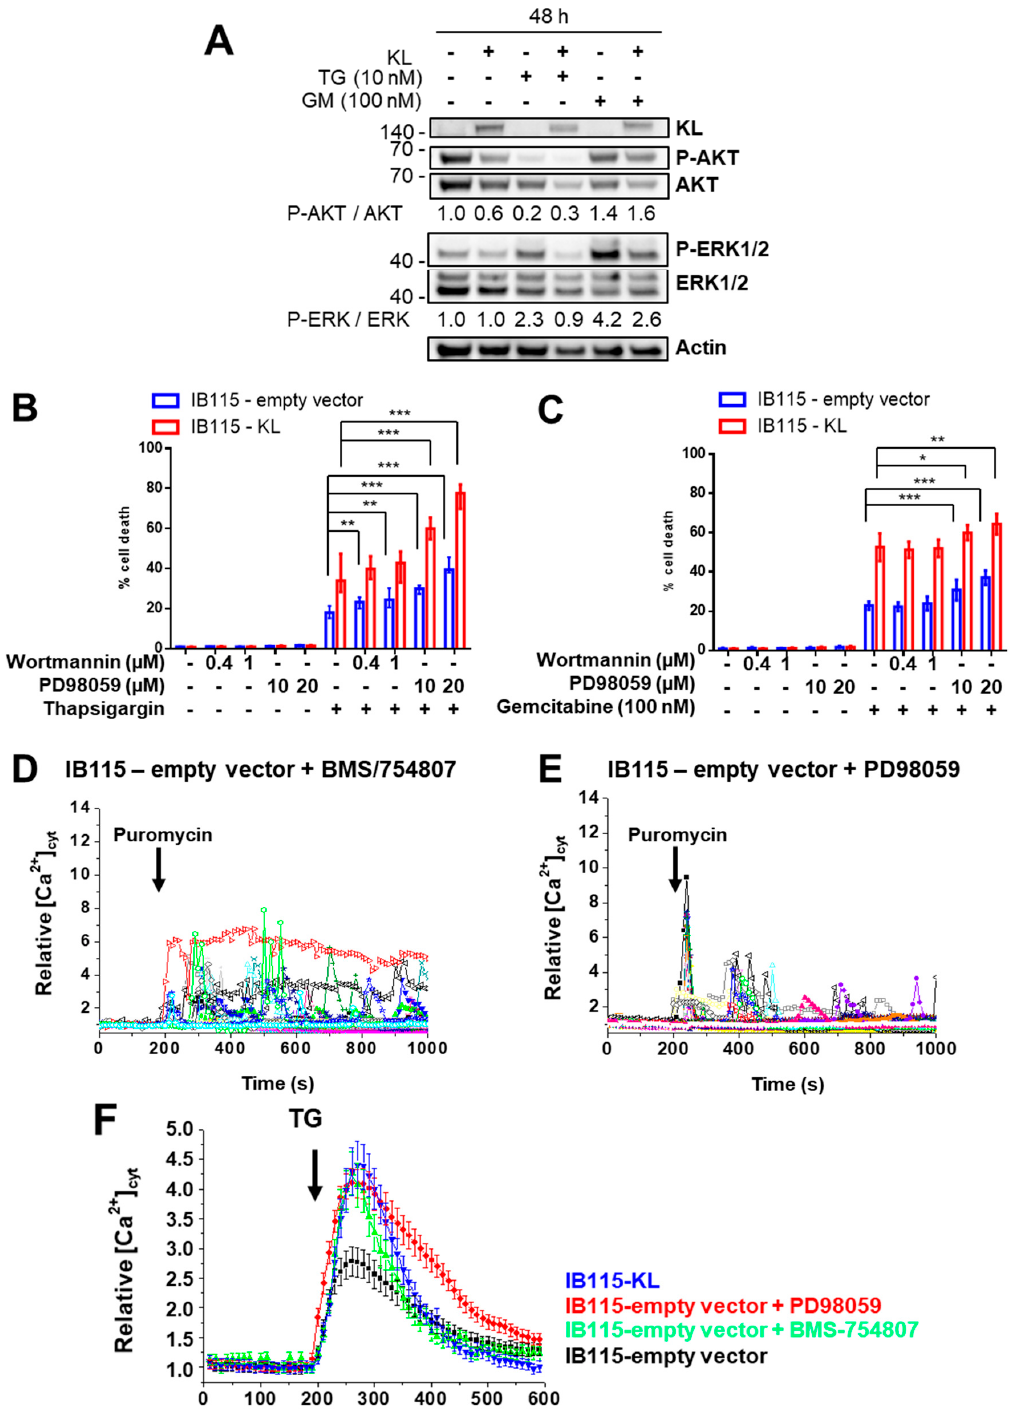
Figure 7. Klotho regulates drug sensitivity and reticular Ca 2+ -leakage by inhibiting ERK1/2 signaling ( A ) Analysis by Western blotting of the abundance of phosphorylated AKT and ERK1/2 compared to total protein expression, in IB115-empty vector and IB115-KL cells after 48 h of incubation with no drugs, 10 nM thapsigargin (TG) or 100 nM gemcitabine. Actin was used as a loading control. To compare the ratios between phosphorylated form and total protein during treatments, results were all normalized to the control condition (IB115-empty vector, no treatment) set to 1. Results are representative of three independent experiments. ( B , C ) Cell death was measured by TMRM-staining and flow cytometry. IB115 cell lines were pretreated for 2 h with Wortmannin or PD98059 as indicated and then incubated for 72 h with ( B ) 20 nM or 10 nM TG for IB115-empty vector and IB115-KL cells, respectively (in order to have an almost similar cell death), or ( C ) 100 nM gemcitabine. Histograms sum up ( B ) four (with median and IQR) and ( C ) three (represented as means ± SD) independent experiments. ( D – F ) Variations of relative cytosolic Ca 2+ concentration were monitored by fluorescence videomicroscopy, in Fluo2-loaded cells bathed in a Ca 2+ -free HBSS medium. ( D , E ) Puromycin (25 µg/mL) was added at 200 s to IB115-empty vector cells pretreated with ( D ) BMS-754807 (50 nM, 24 h) or ( E ) PD98059 (1 µM, 2 h). Each trace corresponds to the evolution of [Ca 2+ ] cyt in one cell. Data shown are representative of three independent experiments. ( F ) TG (10 nM) was added at 200 s to IB115-KL cells ( n = 83) and IB115-empty vector cells, which were not pretreated ( n = 77) or pretreated with BMS- 754807 (50 nM, 24 h, n = 78) or PD98059 (1 µM, 2 h, n = 75). Results correspond to means ± SD. 3. Discussion In this work, we evaluated the relevance of Klotho as a biomarker and as a tool for overcoming drug resistance in high-grade LPS. We reported that a higher KL expression is associated with better survival of LPS patients. Moreover, its expression is detected at higher levels in WDLPS, which has a good prognosis. KL expression is critical for adipose tissue homeostasis but is altered in DDLPS, probably by epigenetic regulations as in several other cancers [53,54]. If in the future the normal tissue of each patient were to be systematically sampled during tumor excision, it would be interesting to confirm these clinical results at the protein level by comparing KL abundance in DDLPS tumors with matched-adipose tissue. Meanwhile, considering our observations at the transcriptomic level, KL downregulation may represent a selective advantage for tumor cells and so, may be associated with tumor evolution as for DDLPS. In compliance with this observation, we did not detect, by western blotting, endogenous KL expression in any of the six DDLPS cell lines, isolated from the patients’ tumors, available in the lab. Moreover, for most of these cell lines, KL overexpression was rapidly eliminated by the transduced cells despite effective lentiviral transduction and cell selection. To assess the cellular role of Klotho in DDLPS, we successfully established a DDLPS cell line stably overexpressing KL. Its inhibitory action on IGF-1-dependent Ca 2+ -signaling was shown through TRPC6 sequestration at the ER and on ERK1/2 activation. Analysis of tumor phenotypes indicated that Klotho reduces cell proliferation, clonogenicity, and has a major effect on drug sensitivity and Ca 2+ homeostasis.